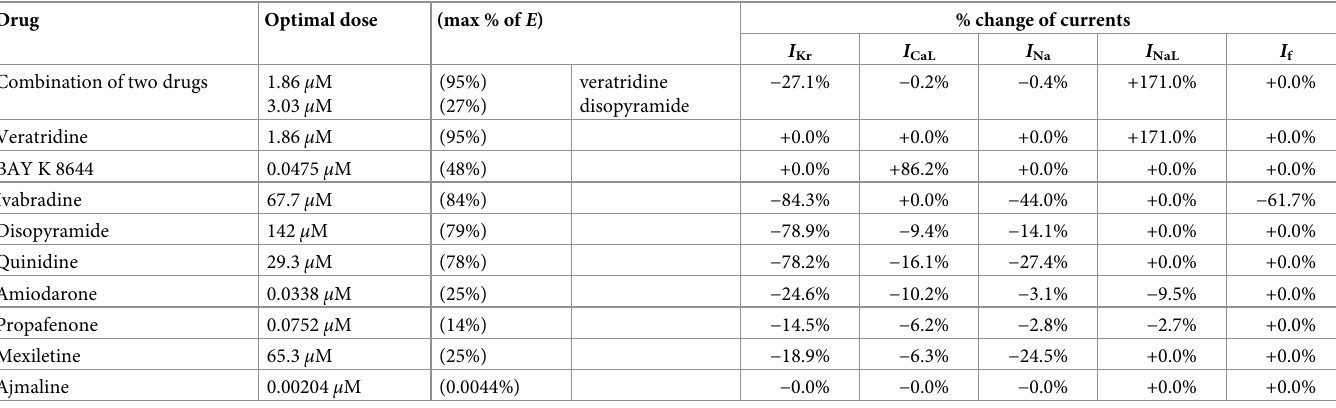
Table 3. Optimal doses and effect on the ion